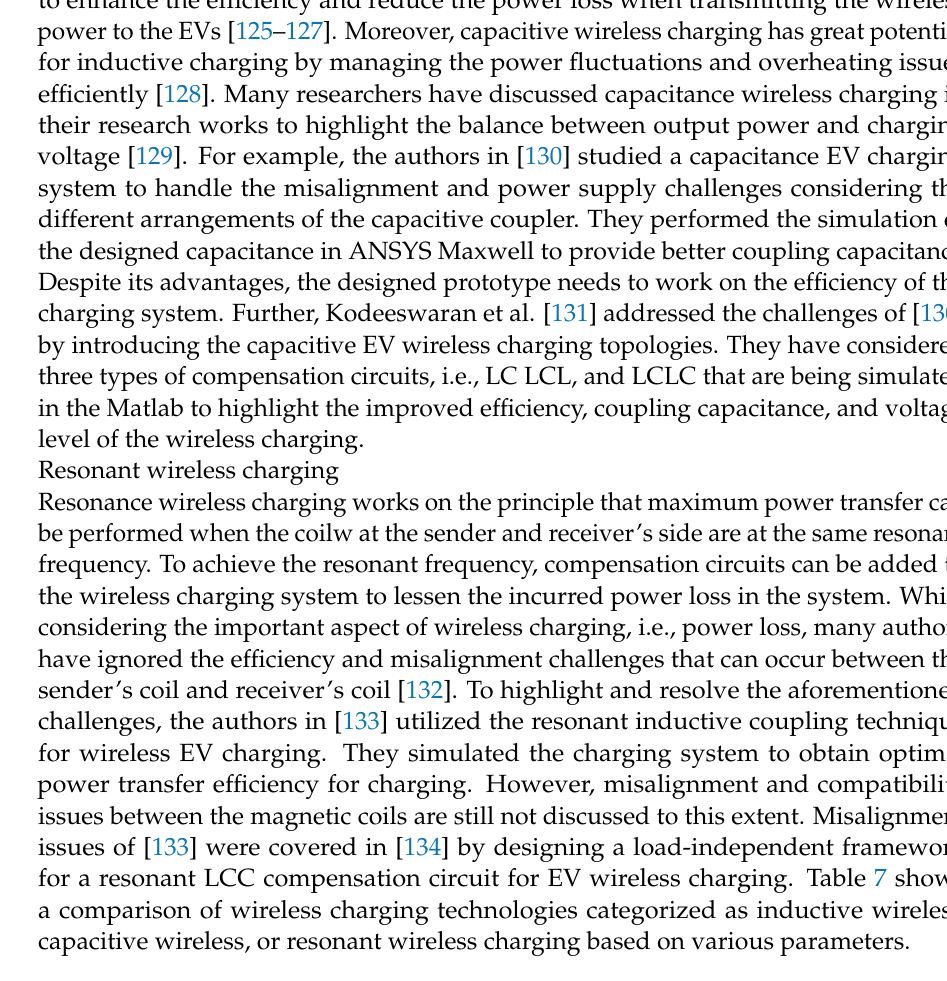
Table 7. Comparison of wireless charging technologies based on the performance evaluation parameters.